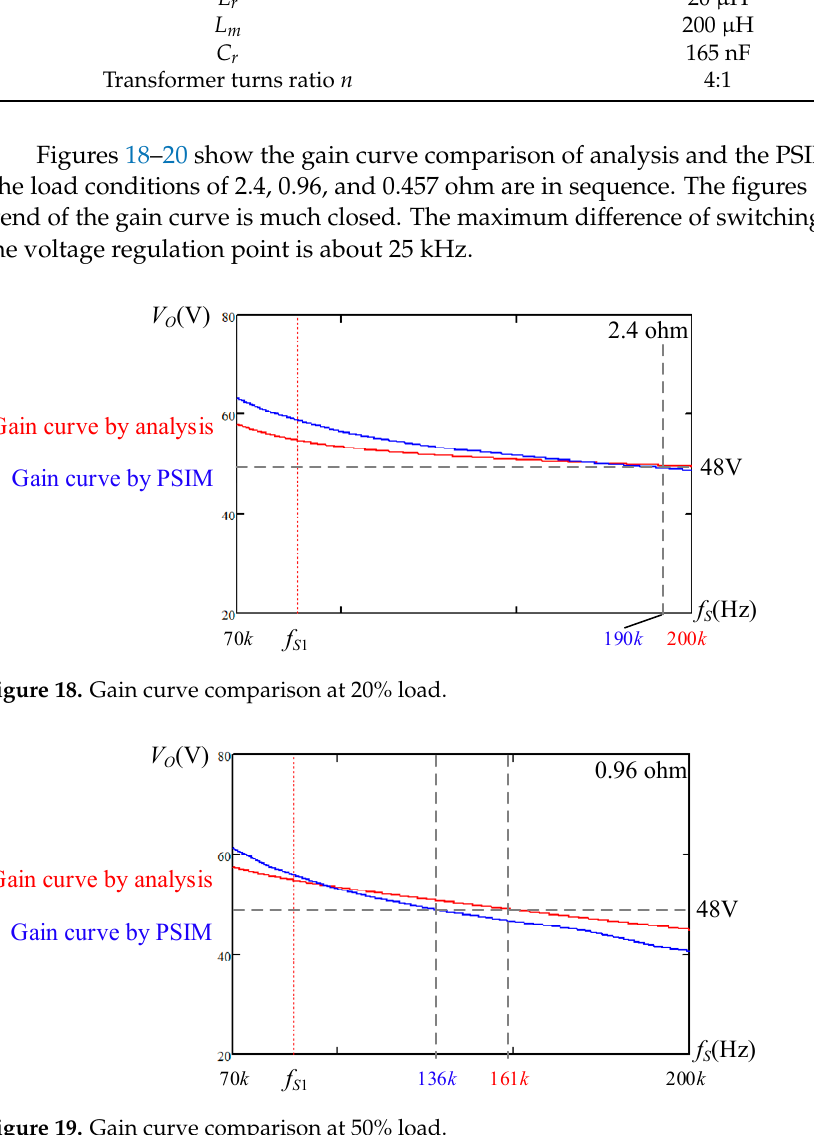
Figure 20. Gain curve comparison at 100% load. 4. Experimental Results This paper uses Table 4 as the specification to realize a prototype 5-kW three-phase wye–delta LLC. Figure 21 shows the operational waveform at 50% and 100% loads. In Figure 21, the 𝑖 (cid:3013)(cid:3045) peak currents of 50% and 100% loads are 8.85 A and 17.47 A, respectively. Figure 22 shows the state–plane from the PSIM simulation. Compared with Figure 17b, the value is closed, the max error of current is 0.2 A, and the max error of voltage is 1.7 V. V gs 2 V gs 1 V gs_SR 2 i Lr 1 v AN v aN v DS_SR 2